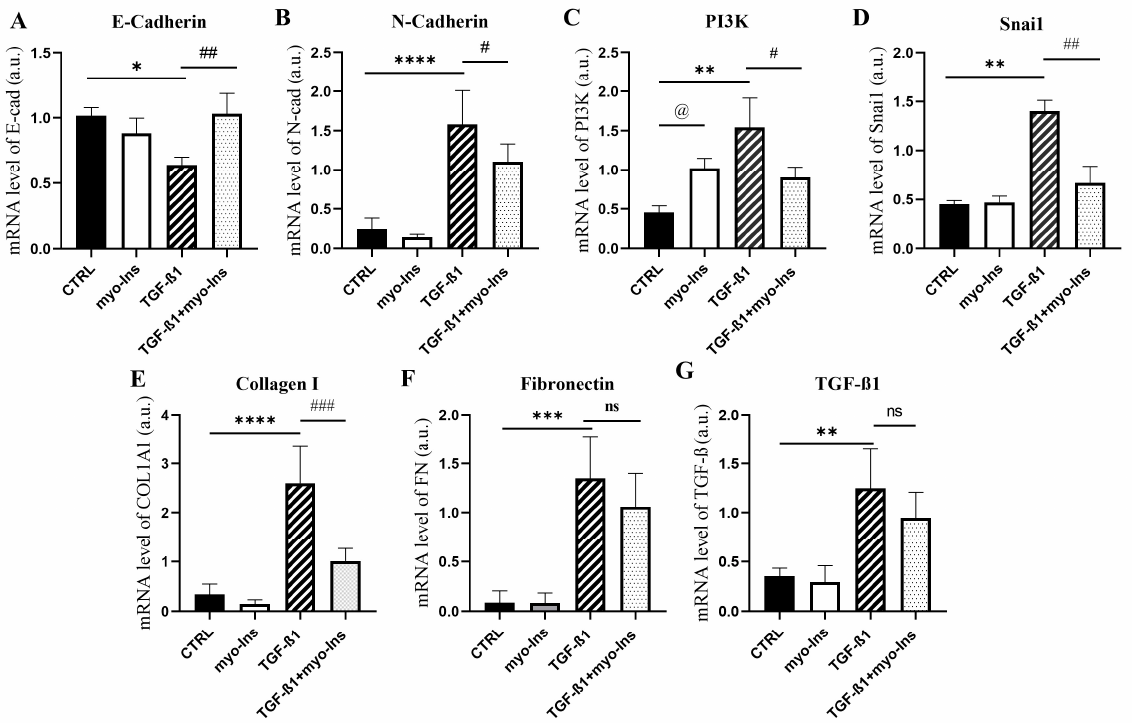
Figure 3. Myo-Ins downregulates the expression of mesenchymal parameters induced by TGF- β 1. qPCR-evaluating levels of E-cadherin ( A ), N-cadherin ( B ), PI3K ( C ), Snail ( D ), Collagen ( E ), Fibronectin ( F ), and TGF- β 1 ( G ) in MCF-10A cells treated with TGF- β 1 alone or in combination with myo-Ins. The addition of myo-Ins induces, as early as after one hour, a significant reversion of all but one (fibronectin) of the investigated parameters. This result indicates that myo-Ins exerts a pleiotropic effect upon several pathways instrumental in fostering the mesenchymal–epithelial transition (MET). Histograms are expressed as relative expressions of three independent experiments (mean ± SEM). GAPDH was used for housekeeping. One-way ANOVA statistical analysis: * p < 0.05; ** p < 0.01; *** p < 0.001; **** p < 0.0001. # p < 0.05; ## p < 0.01; ### p < 0.001; @ p < 0.05; ns: no significance. Legend: *: TGF- β 1 vs. CTRL; # TGF- β 1+myo-Ins vs. TGF- β 1; @: myo-Ins vs